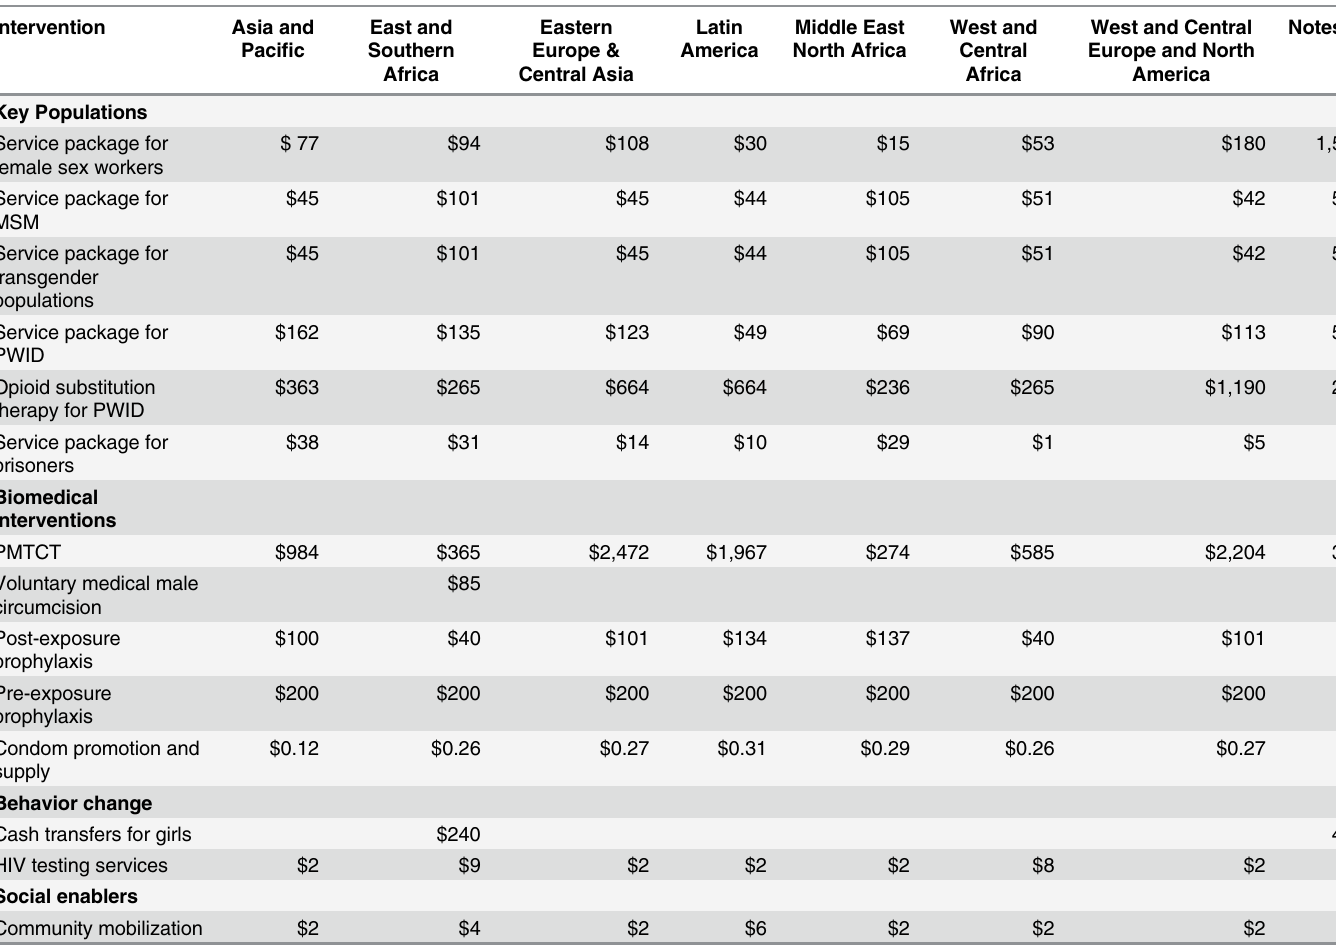
Table 2. Regional average costs per person reached (in 2015 USD